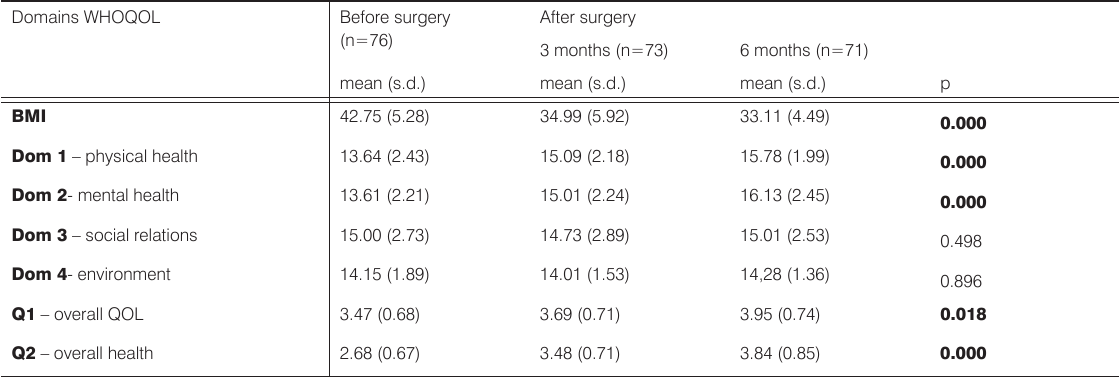
Table 2. The comparison of BMI and WHOQOL-BREF score in morbidly obese patients before surgery and 3 - 6 months after